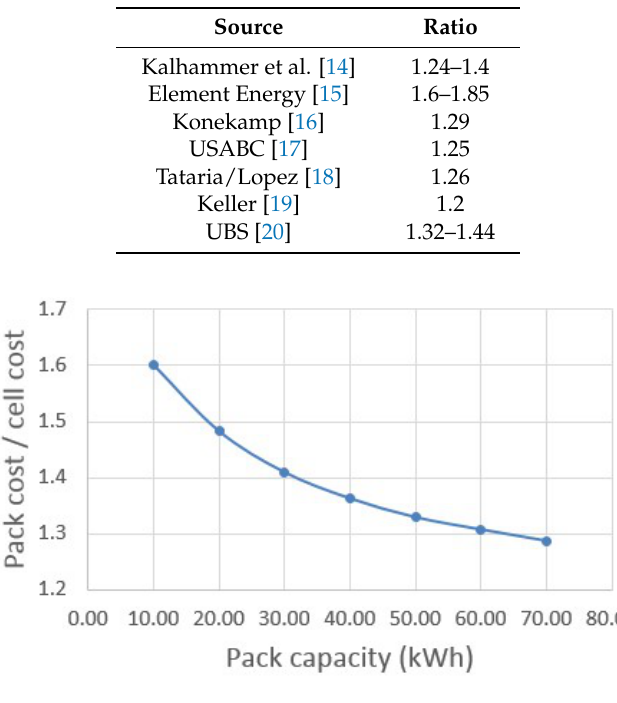
Figure 4. Ratio of pack cost to cell cost computed by BatPaC for pack topology similar to Chevy Bolt.